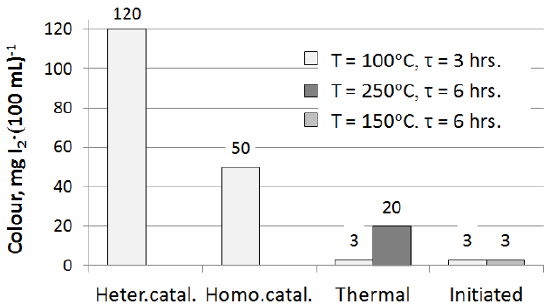
Figure 7. Colour of the cooligomers synthesized by different